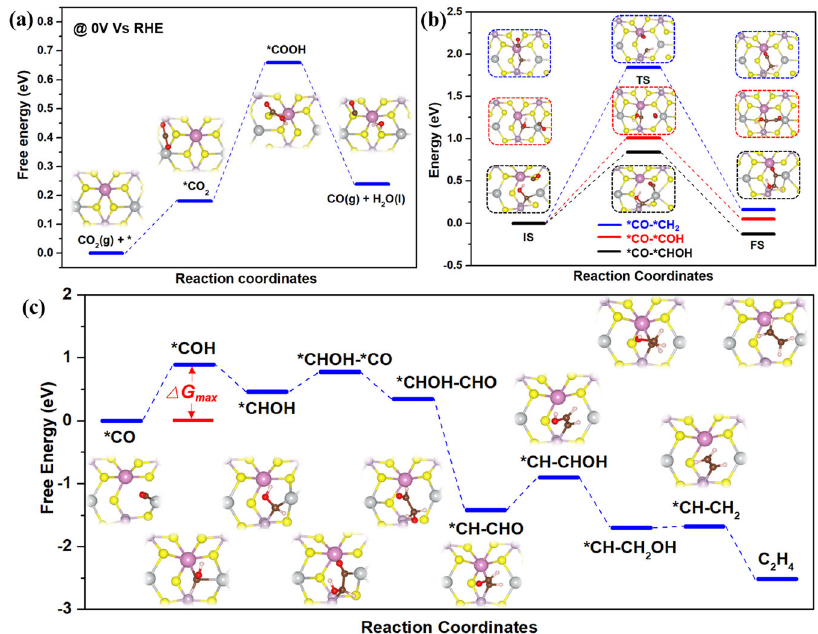
Fig. 4 Theoretical investigations. a Gibbs free energy diagrams for CO 2 reduction to CO over perfect AgInP 2 S 6 . b Three kinds of possible C – C coupling pathways over AgInP 2 S 6 containing V s . c Gibbs free energy diagrams for CO reduction to C 2 H 4 over AgInP 2 S 6 with V s . The insets show the corresponding optimized geometries for the reaction intermediates during the CO 2 reduction process. Sulfur, phosphorus, indium, silver, carbon, oxygen, and hydrogen atoms are yellow, purple, lilac, gray, black, red, and white,